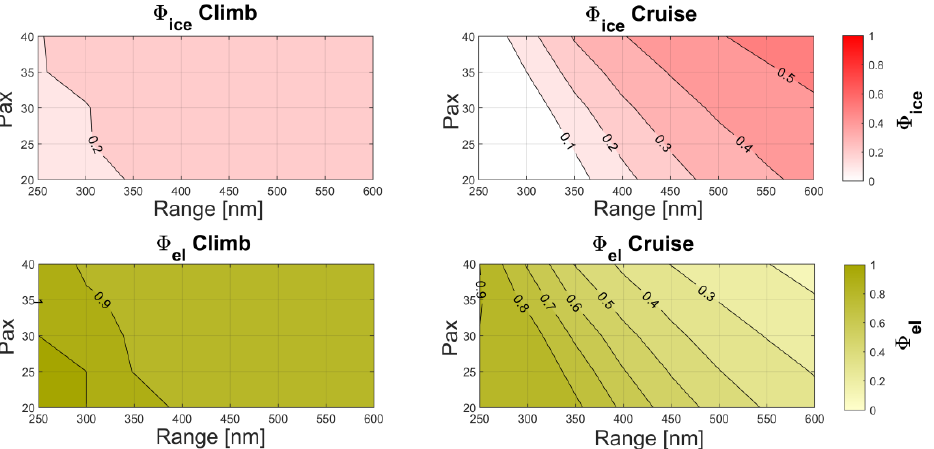
Figure 12. As in the case of the design point, in this case the Φ ice are also constant within each phase, whereas Φ el are time variables, depending on Φ(t) ; so, at the bottom of Fig- ure 12, the values of Φ el at the beginning of the climb (left) and cruise (right) are reported.